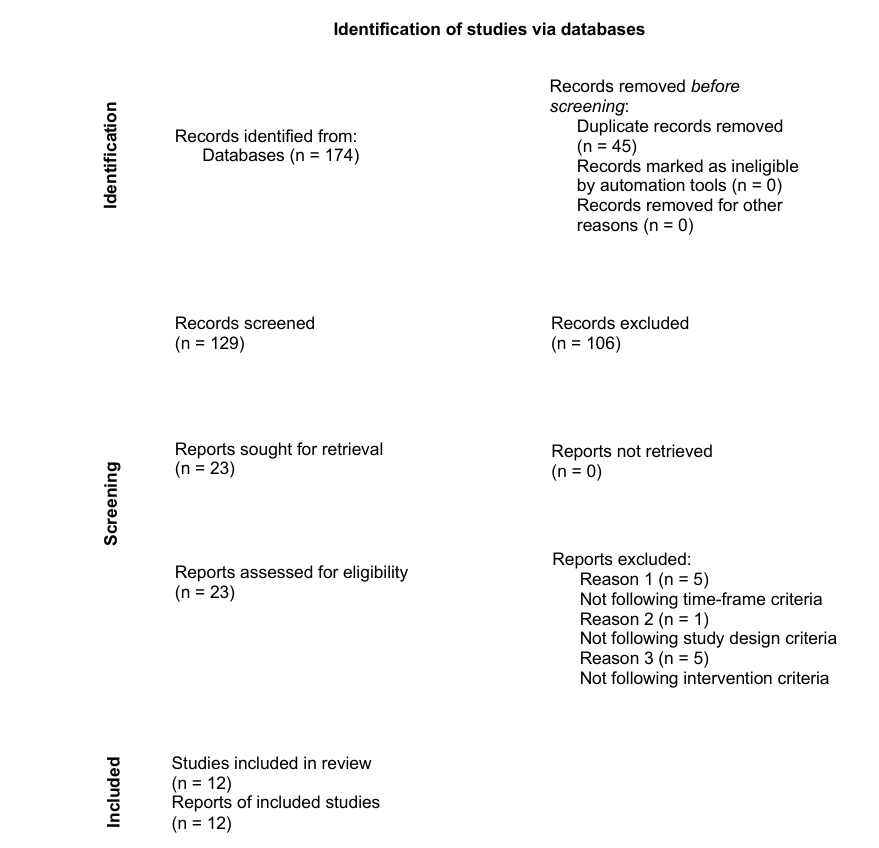
Figure 1. Flow diagram for the study selection process.